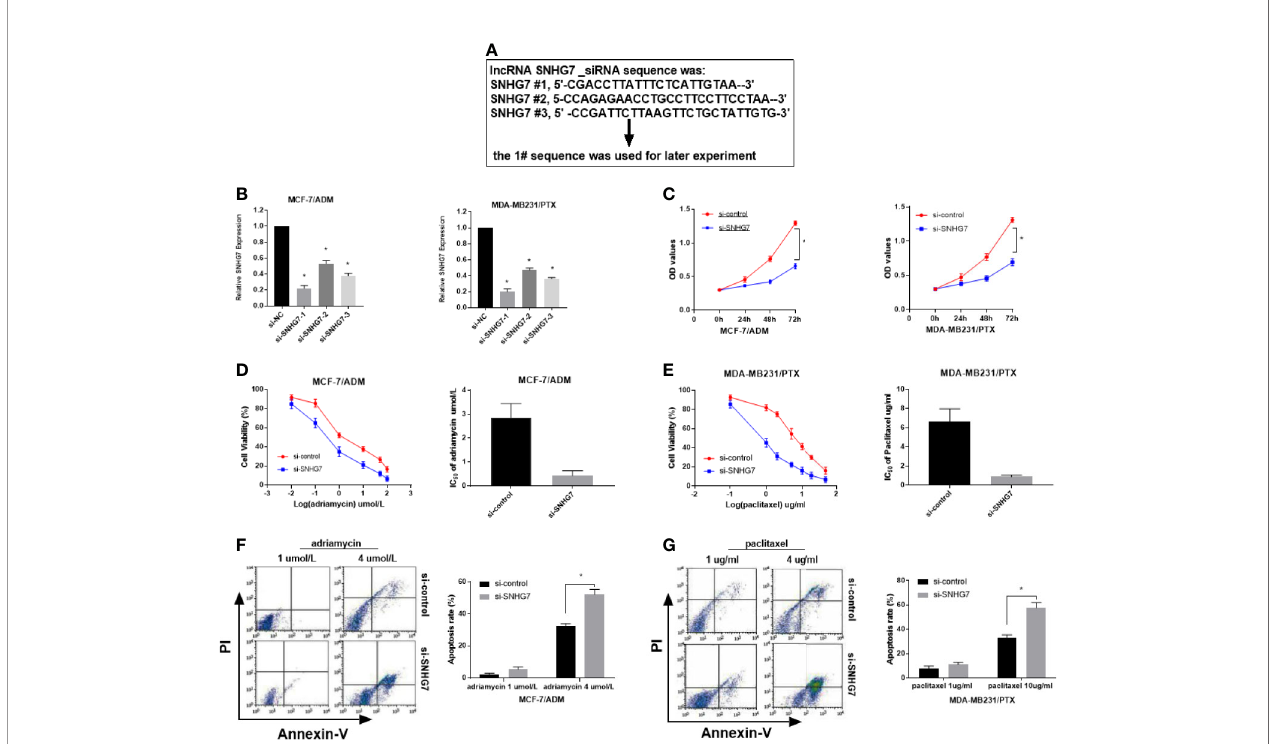
FIGURE 3 | Knockdown of SNHG7 promoted the sensitivity of chemoresistant breast cancer cells. (A) Three interference sequences of lncRNA SNHG7. (B) qRT- PCR analysis was performed in MCF-7/ADR and MDA-MB-231/PTX cells transfected with SNHG7 siRNAs (si-SNHG7 #1, si-SNHG7 #2 or si-SNHG #3) or si- control. (C) Cell viability was evaluated in MCF-7/ADR and MDA-MB-231/PTX cells transfected with si-SNHG7 or si-control by MTT assay. (D, E) Cell viability was determined by MTT assay in transfected MCF-7/ADR and MDA-MB-231/PTX cells treated with various concentrations of adriamycin and paclitaxel. (F, G) Cell apoptosis was evaluated by fl ow cytometry analysis in transfected MCF-7/ADR and MDA-MB-231/PTX cells after treatment with adriamycin or paclitaxel, respectively. *P <